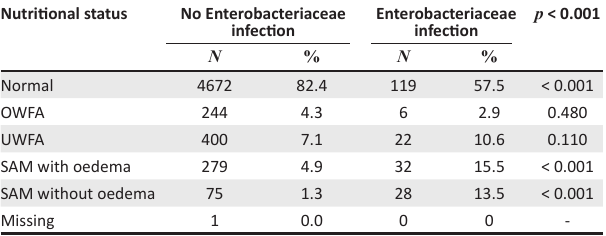
TABLE 2: Nutritional status and Enterobacteriacae infections.